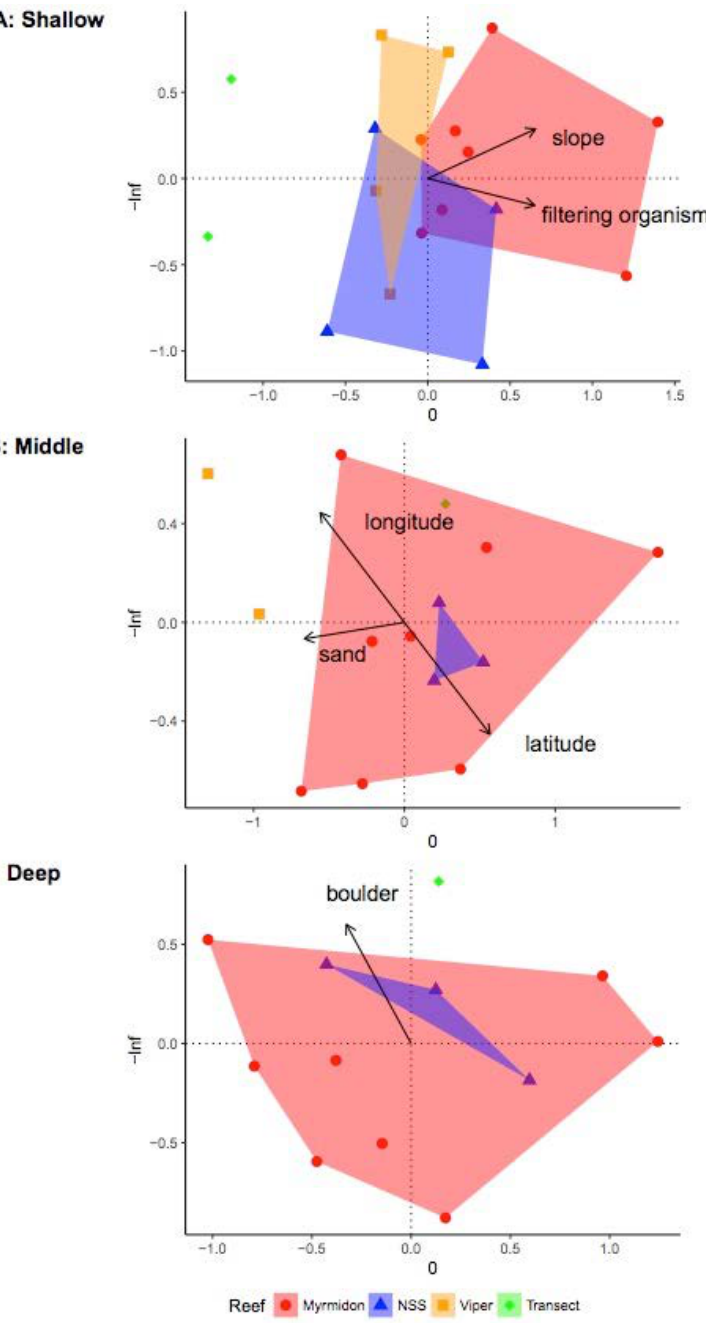
Figure 6. Nonmetric Multidimensional Scaling (nMDS) showed patterns between fish community composition and environmental variables, including epibenthic and substratum measured in the underwater camera field-of-view and multibeam echo sounder measured variables. Sites were separated into Shallow (54–115 m, nMDS non-metric fit, R 2 = 0.967, linear fit, R 2 = 0.827, stress = 0.21, top), Middle (128–160 m, nMDS non-metric fit, R 2 = 0981, linear fit, R 2 = 0.913, stress = 0.15, middle), and Deep (179–260 m, nMDS non-metric fit, R 2 = 0.989, linear fit, R 2 = 0.924, stress = 0.15, bottom) based on depth. Ordination from Bray-Curtis dissimilarities in species abundance data, transformed using fourth-root transformation, and standardized using Wisconsin-double standardization. Colored hulls show the affiliation of each site to a location. Environmental variables that were significant within these depth strata are depicted as vectors on the nMDS ordination ( p < 0.05, 999 permutations).